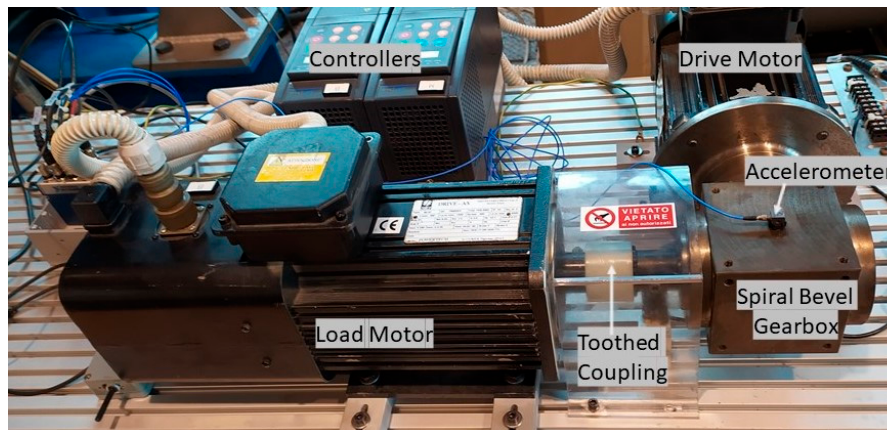
Figure 3. Test rig layout.